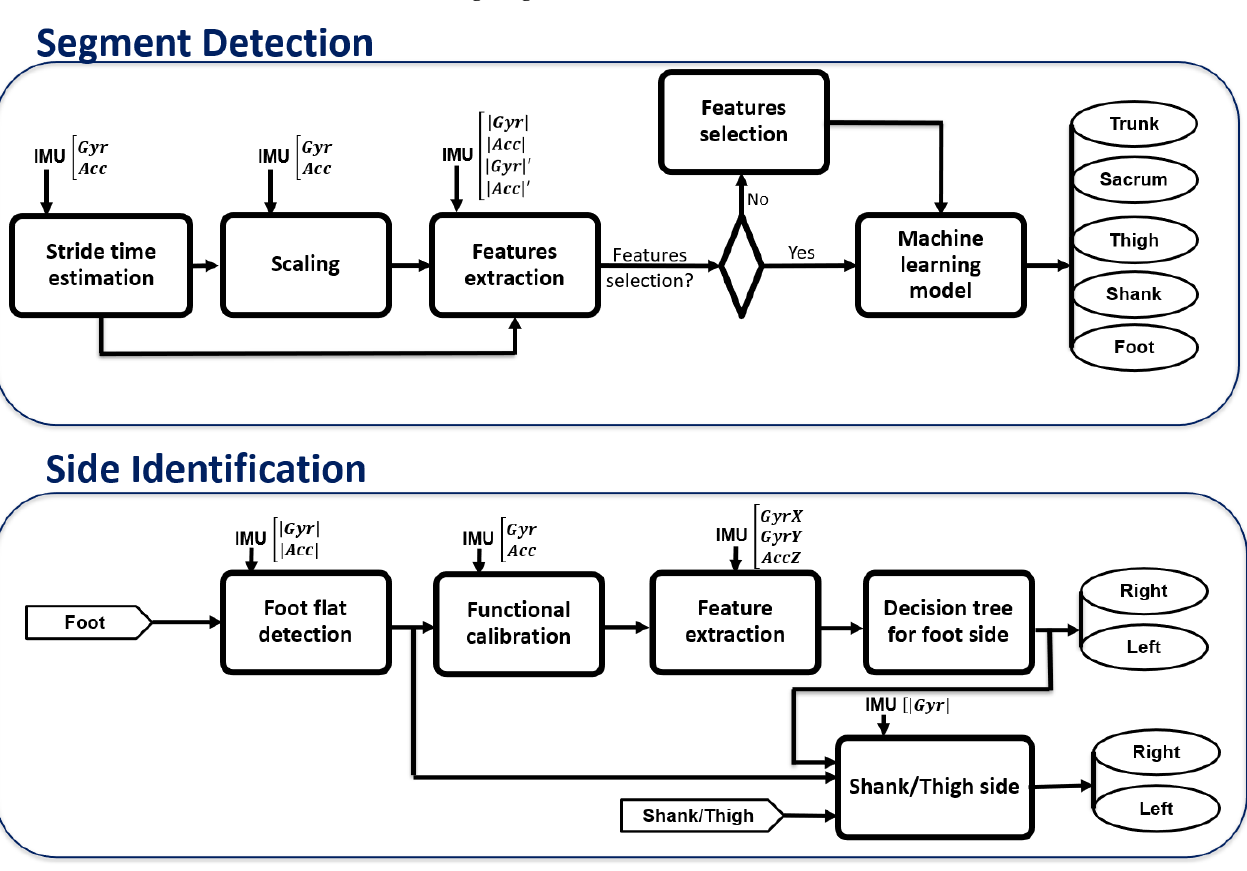
Figure 2. Overview of the I2S pairing with the IMU input corresponding to each of the used signals. The inputs of the side identification algorithm are the foot, shank, and thigh sensors detected in the first part.